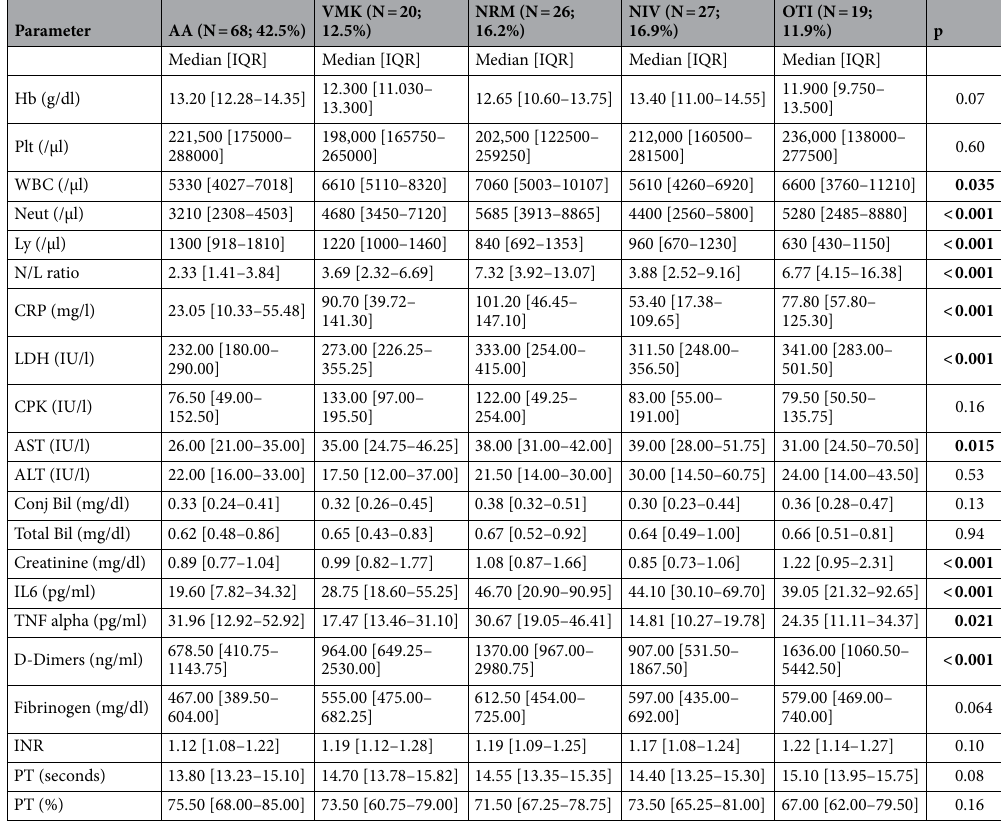
Table 5. Laboratory parameters at baseline after patient stratification according to maximal oxygen supply/ ventilation support. Statistically significant p values are highlited in bold. Reference values: Hb (g/dl):